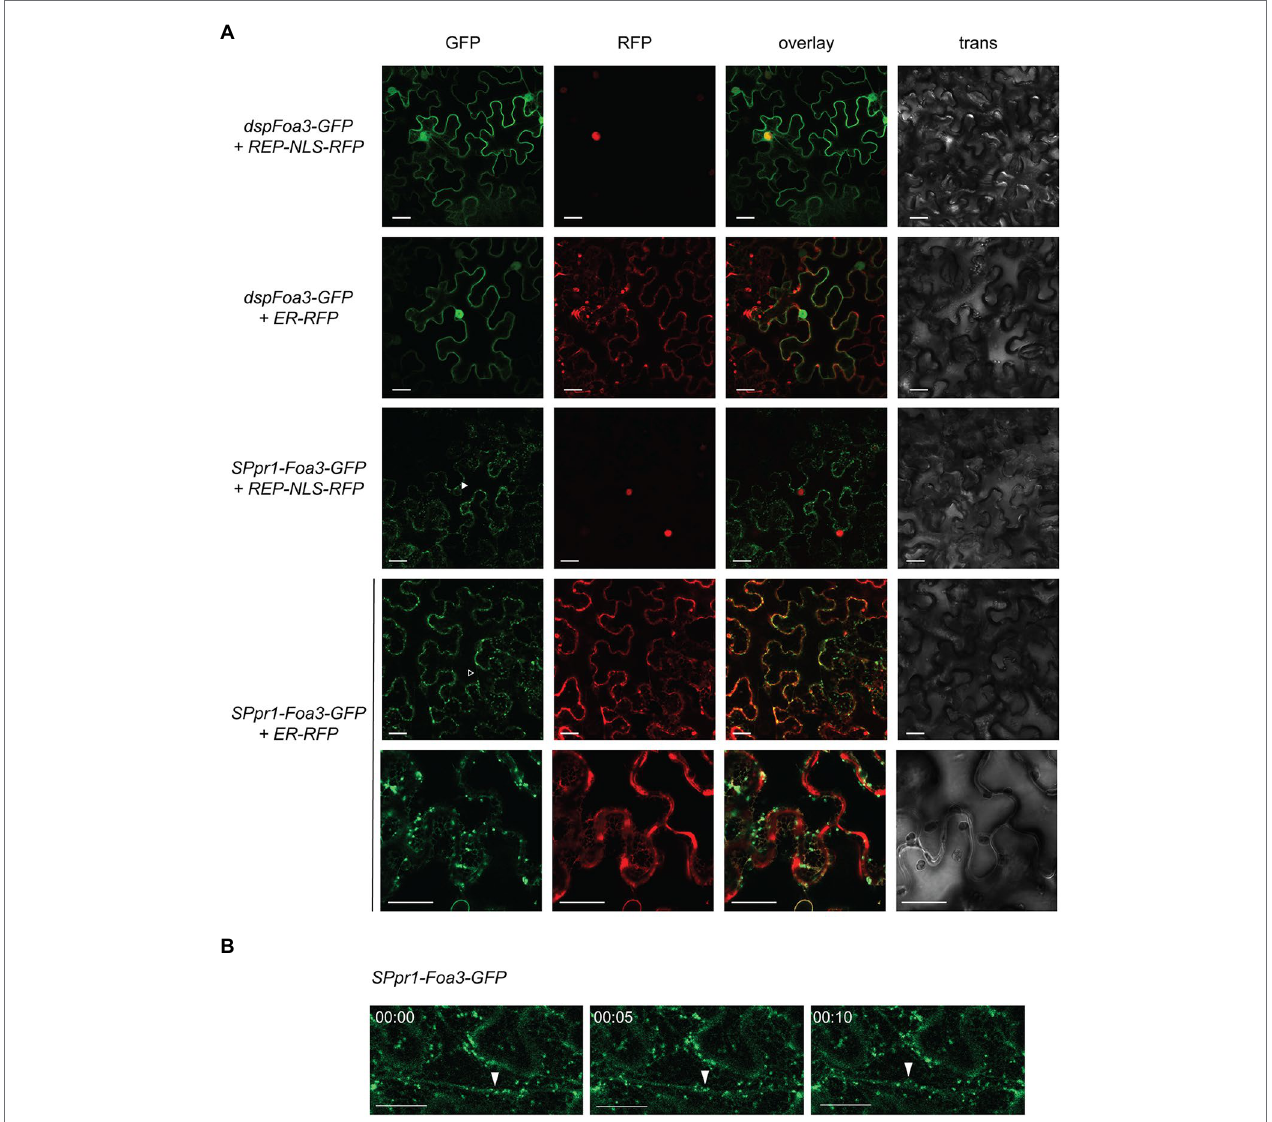
FIGURE 2 | Subcellular localization of Foa3 produced with (sp) or without (dsp) a secretory signal peptide. (A) Confocal microscopy of Agro-infiltrated Nicotiana benthamiana leaves expressing the indicated constructs. Closed arrowhead indicates SPpr1-Foa3-GFP accumulating around a nucleus. Open arrowhead indicates SPpr1-Foa3-GFP at cytosolic strands. Size bars = 20 μ m. (B) Time-lapse confocal images showing accumulation of SPpr1-Foa3-GFP in mobile subcellular structures. Closed arrows indicate Foa3-GFP labelled puncta moving along cytosolic